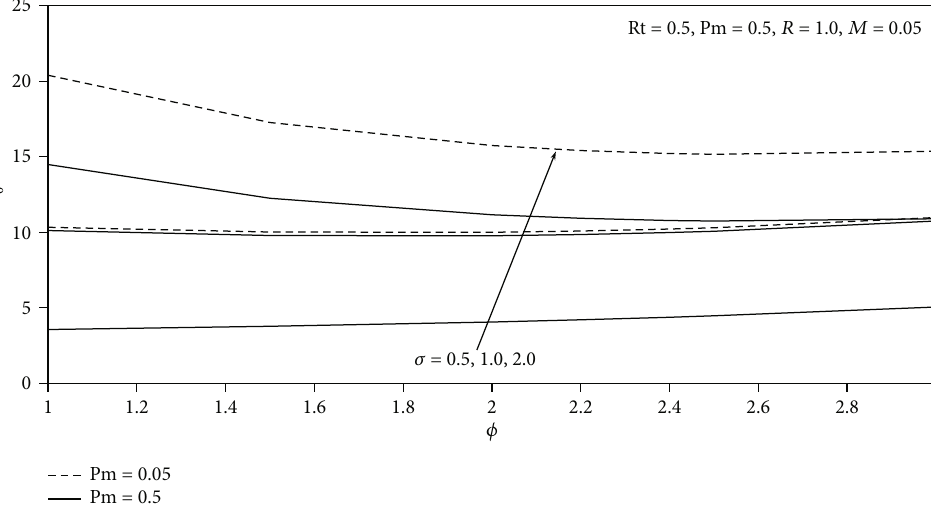
ϕ for di ff erent values of Pm and σ 0 Þ versus